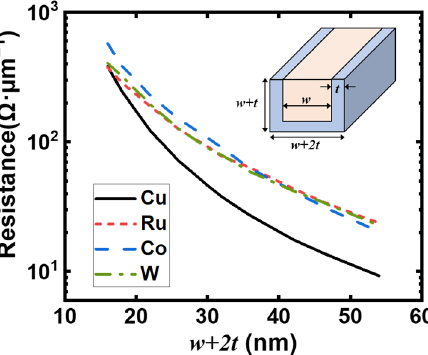
Figure 5. The calculated resistance per μ m with liner thickness t Cu = 3 nm, t Ru = 0.3 nm, t Co = 1 nm, and t W = 0 nm. The inset demonstrates the structure of interconnect with the presence of liners and barriers. w is the width of the metallic lines, t the thickness of liner and barrier. All scattering mechanisms are included.